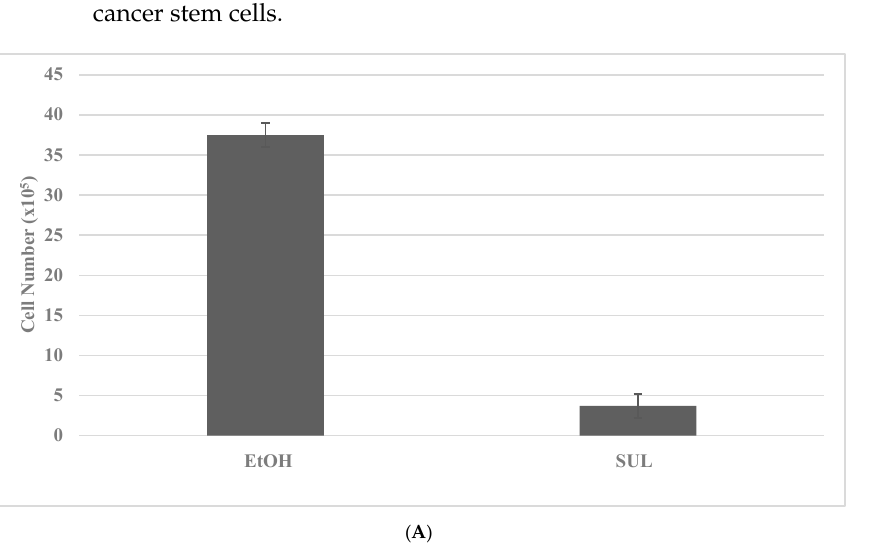
Figure 2. Isolation of drug-resistant putative stem cells in breast cancer models. ( A ) Decreased viable cell number by treatment with TAM in TAM-S cells. EtOH versus TAM p = 0.01. ( B ) Increased tumor spheroid number in TAM-R cells. TAM-S versus TAM-R p = 0.01. ( C ) Decreased viable cell number by treatment with DOX in DOX-S cells. EtOH versus DOX p = 0.01. ( D ) Increased tumor spheroid number in DOX-R cells. DOX-S versus DOX-R p = 0.01. Data analyzed by the two-way Student’s t test. TAM, tamoxifen; TAM-S, TAM sensitive; TAM-R, TAM resistant; EtOH, ethanol; DOX, doxo-